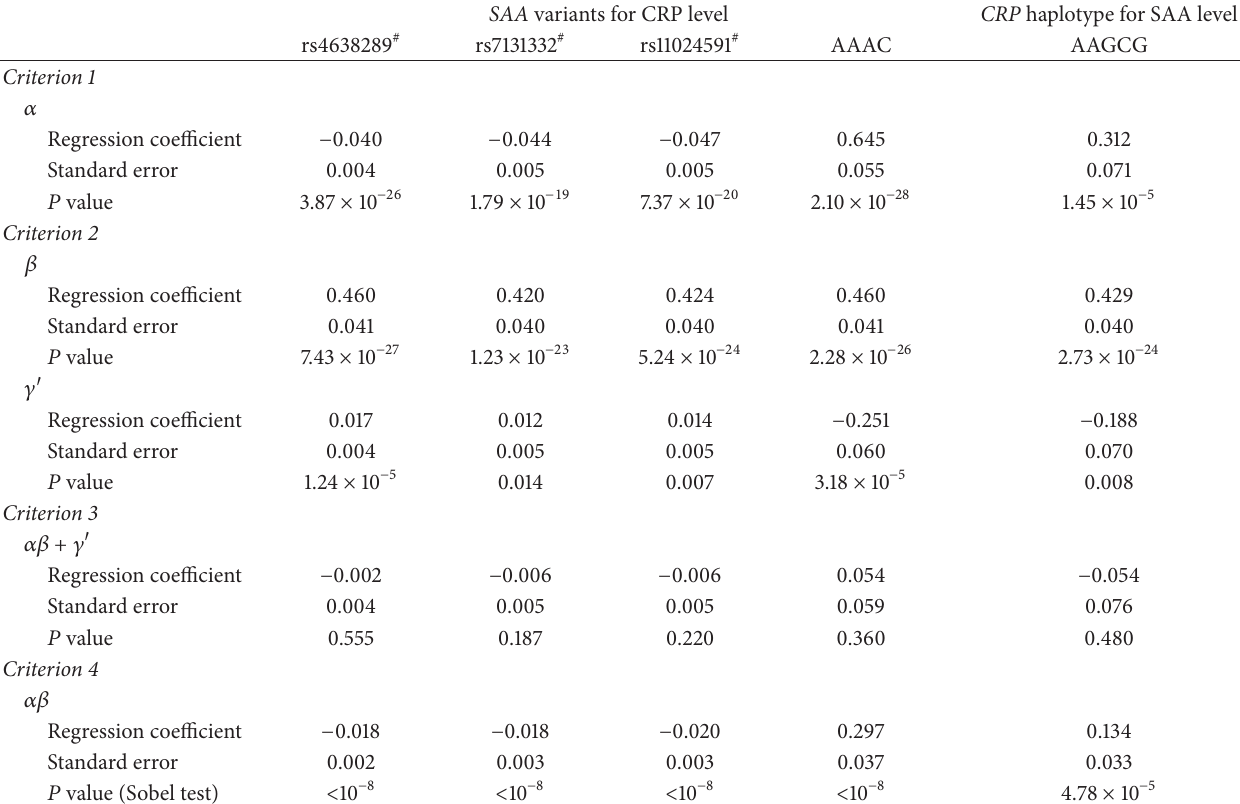
Table 5: Mediation test of CRP and SAA levels in the association of CRP and SAA1 genotypes/haplotypes with SAA and CRP